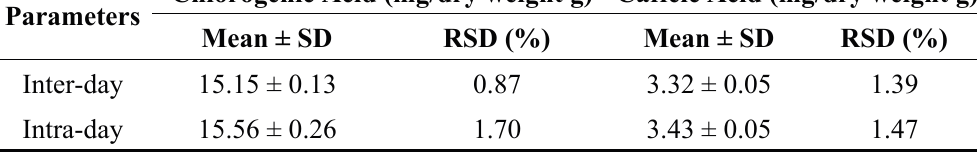
Table 4. Precision studies of chlorogenic acid and caffeic acid analysis for the determination in the leaf extract of A. senticosus .